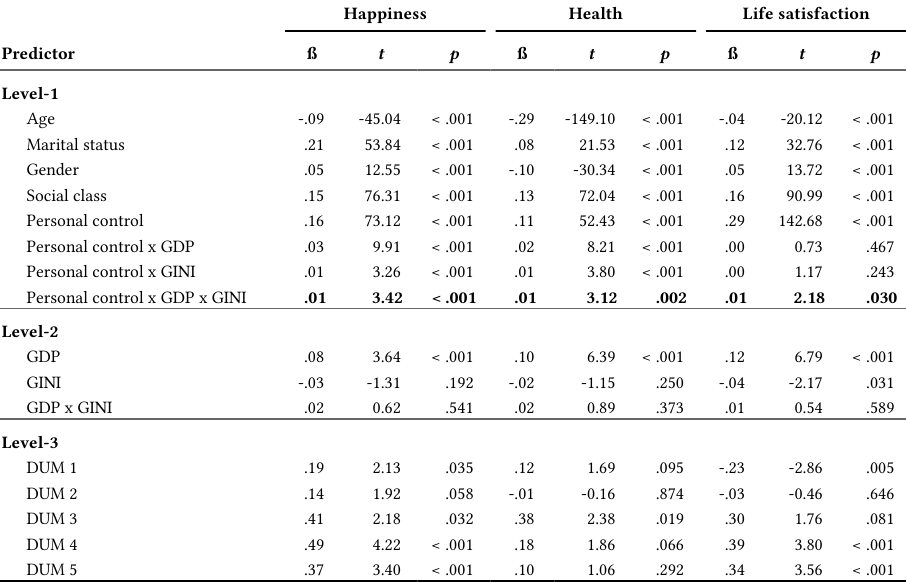
Personal Control as Moderator of the Effects of GDP and Gini on Well-Being Outcome Happiness Health Life Predictor